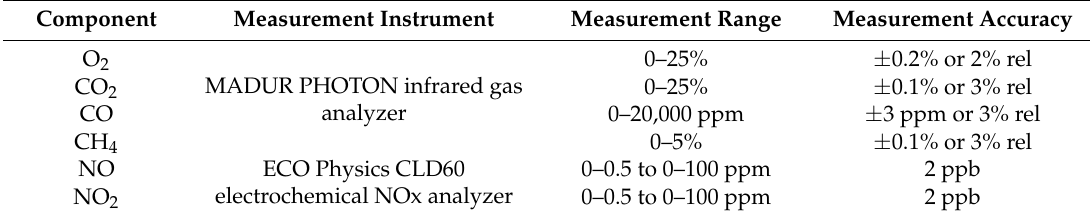
Table 1. Measurement range and measurement accuracy of the gas analyzer for different gas